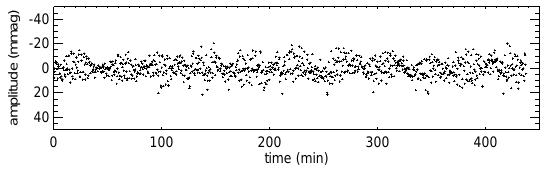
Figure 3. Day to day amplitude variation of PG 1613+426 (May-June, 2011) for F1 (top) and F2 (bottom) pulsations. Except days 717-719 in F2, both F1 and F2 amplitudes look stable. Days 717-719 in F2 show that the amplitude is